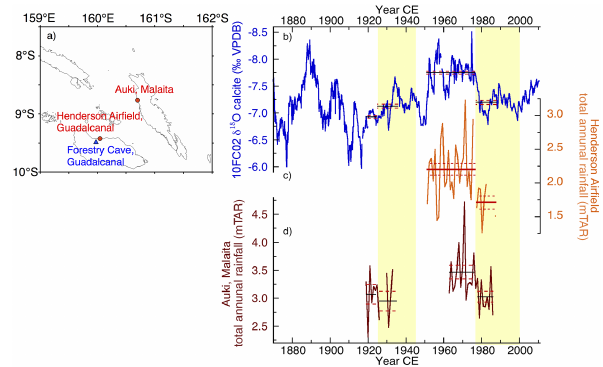
Figure 6. Comparison between stalagmite δ 18 O and local rainfall records. (a) Location map of Forestry Cave (blue triangle) and rain gauge data sites (red circles: Henderson Airfield, Honiara, Guadal- canal; Auki, Malaita, Solomon Islands). (b) δ 18 O variations in sta- lagmite 10FC-02 from 1870 to 2009. Total annual rainfall (TAR; data from Deser et al. (2004) and Vose et al. (1992)) at (c) Hender- son Airfield and (d) Auki. Mean (solid horizontal lines) and stan- dard error (dashed horizontal lines) of TAR values associated with select epoch intervals of PDV are also shown. Beige stippled (white) area highlights positive (negative) phases of the Interdecadal Pacific Oscillation (IPO; Folland et al.,